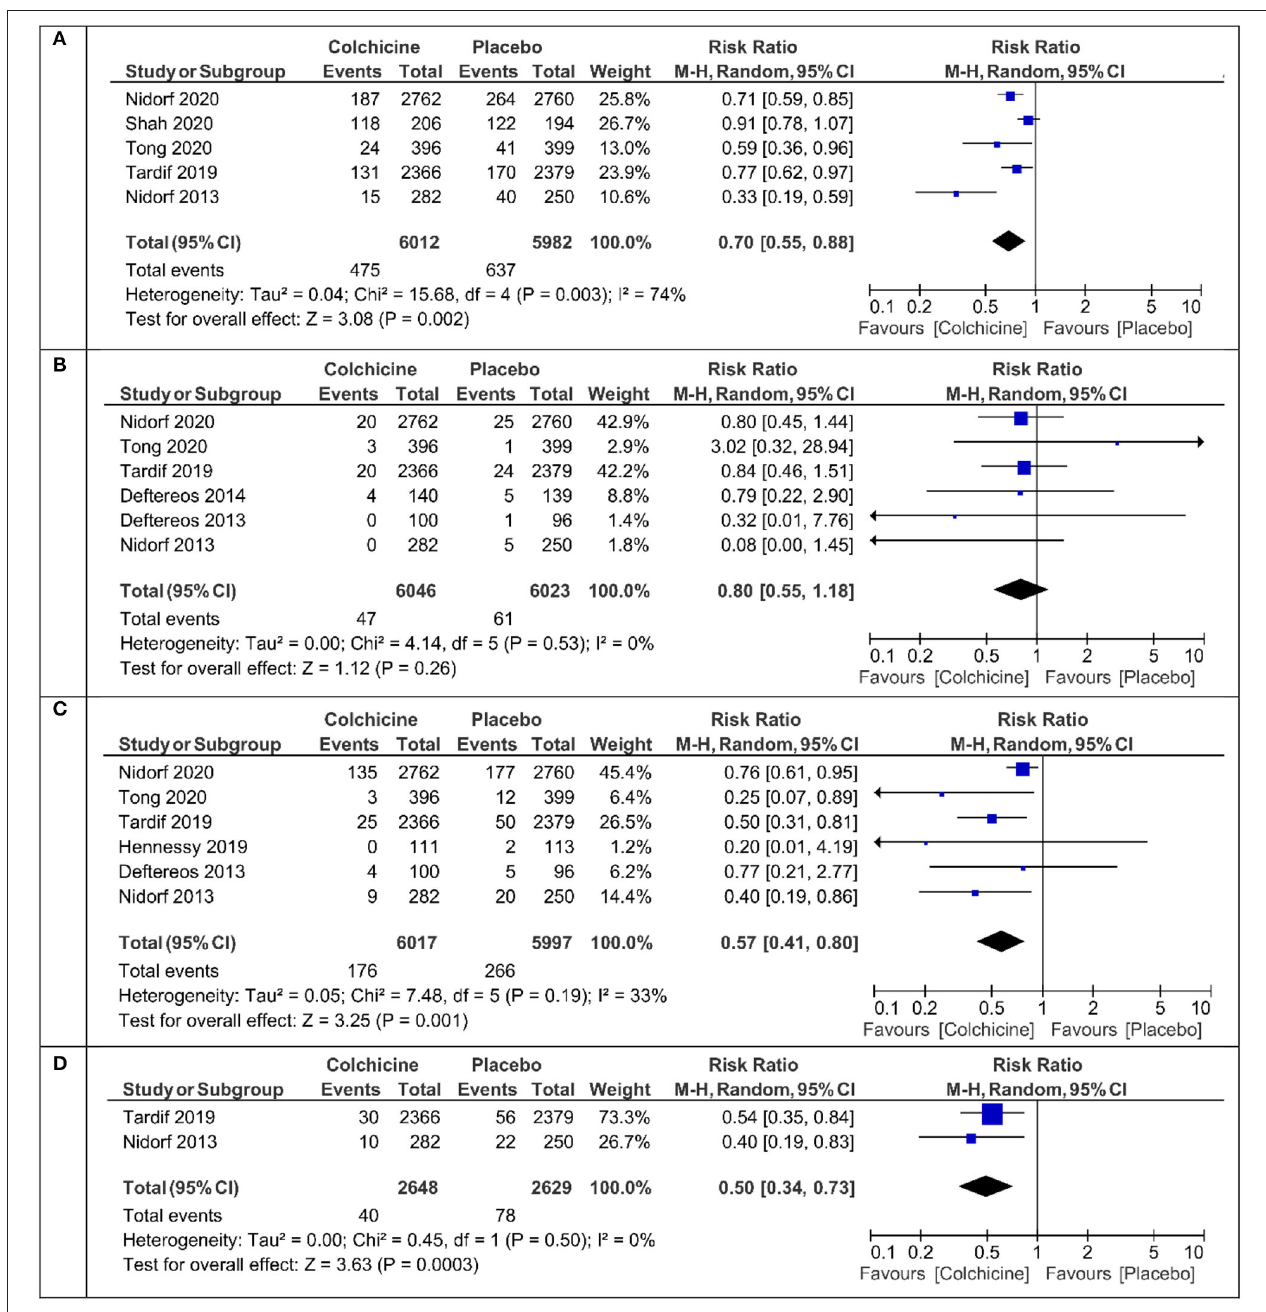
FIGURE 2 | Meta-analysis results for the primary endpoint, cardiovascular death, ischemia driven revascularization, and ischemia driven revascularization + resuscitation. (A) Primary endpoint, (B) cardiovascular mortality, (C) ischemia driven revascularization, (D) ischemia driven revascularization + resuscitation.